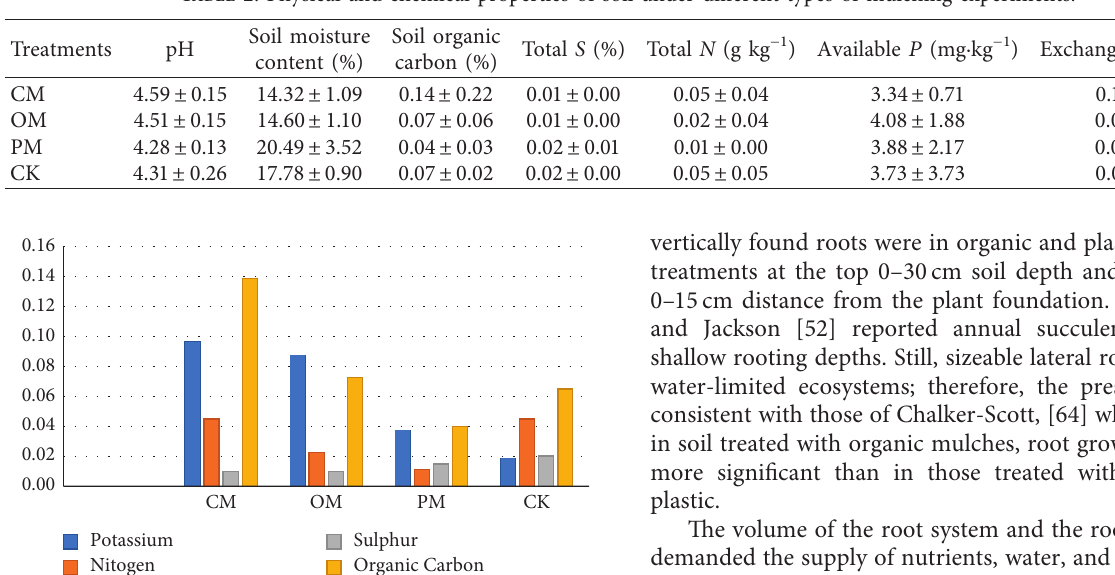
Figure 10: Exchange potassium, total nitrogen, total sulphur, and soil organic